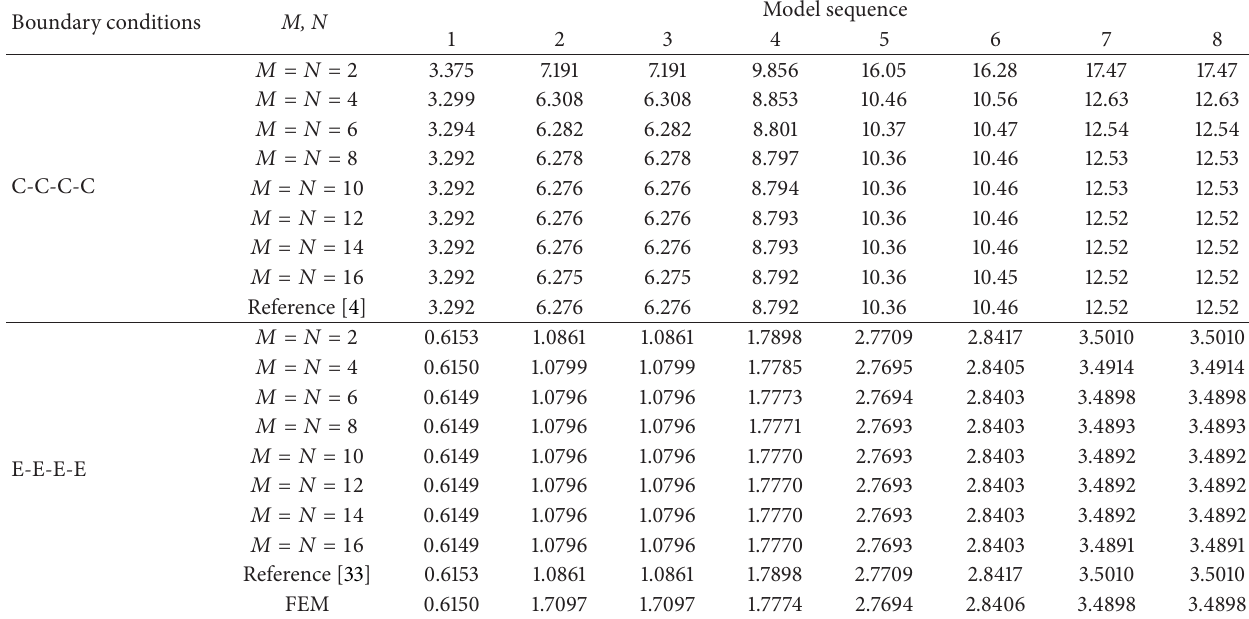
Table 1: Frequency parameters Ω = 𝜔𝑏 2 (𝜌ℎ/𝐷) 1/2 /𝜋 2 for square moderately thick plates with uniform thickness and different boundary